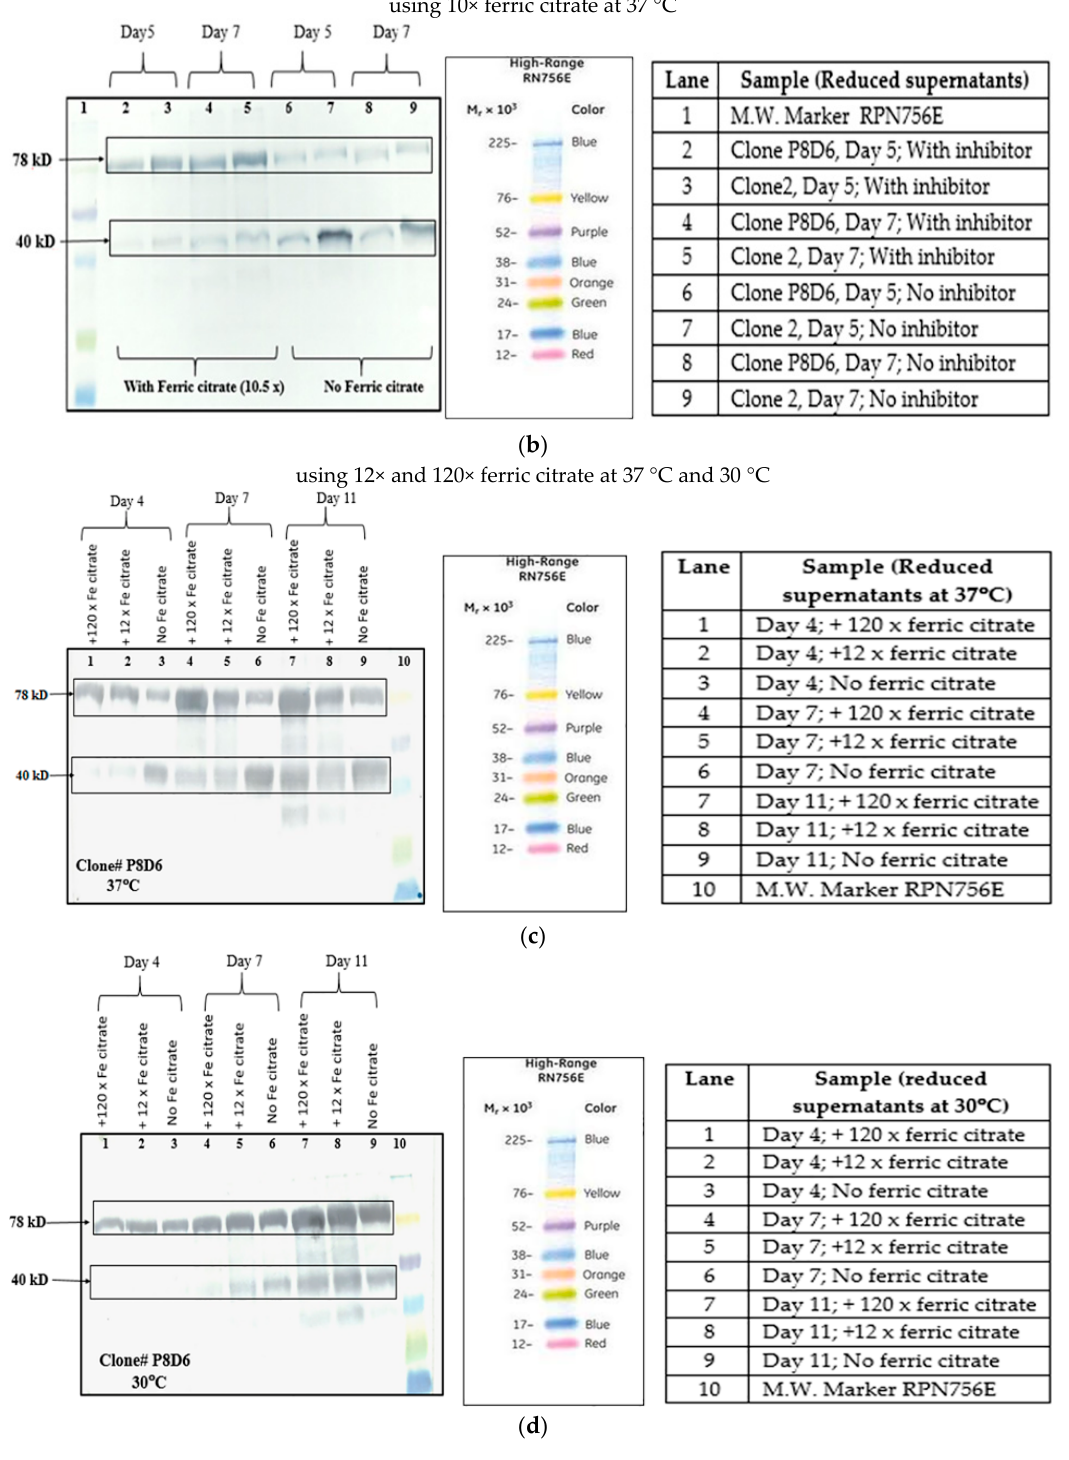
Figure 2. ( a ) Western Blot for VEGFR1(D1–D3)-Fc expression with and without 10× ferric citrate in culture supernatant for two different clones; ( b ) Western Blot for VEGFR1(D1-D3)-Fc expression with and without 10× ferric citrate in culture; ( c ) effect of ferric citrate on reduction of proteolysis in VEGFR1(D1-D3)-Fc at 37 °C; ( d ) effect of ferric citrate on reduction of proteolysis in VEGFR1(D1-D3)-Fc at 30 °C.